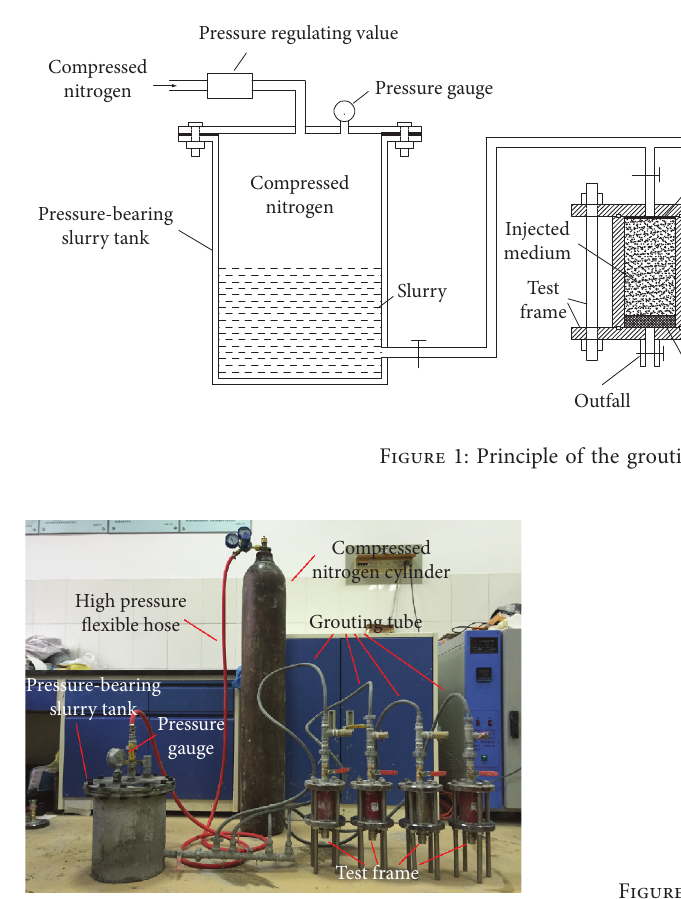
Figure 2: Photograph of the grouting test device.